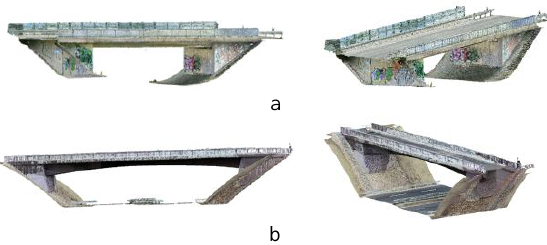
Figure 8. Overview of the data: a: bridge 1; and b: bridge 2.